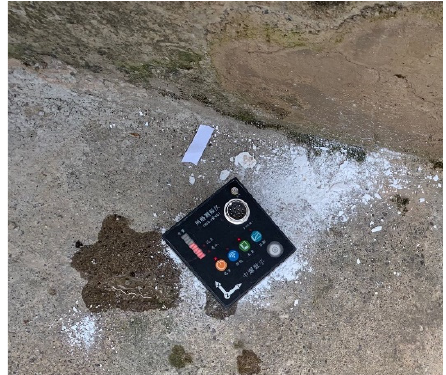
Figure 1. Monitoring point